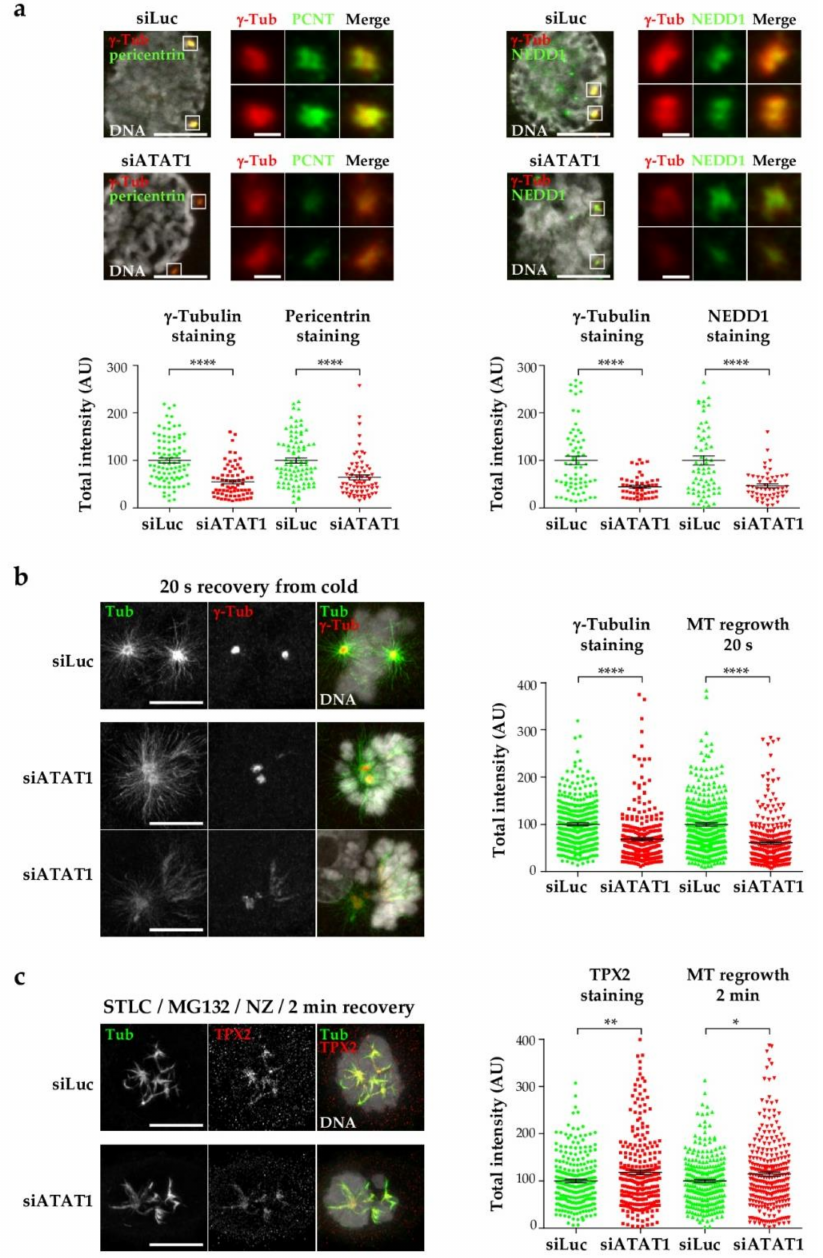
Figure 3. Centrosome maturation and nucleation are deficient in si ATAT1 cells. LLCPK1 cells were transfected for 48 h with siRNAs directed against luciferase or ATAT1 . ( a ) Cells were fixed and processed for immunofluorescence. Representative MIP images of prophase siLuc and si ATAT1 cells stained for γ -tubulin and pericentrin (left panels) and γ -tubulin and NEDD1 (right panel) are shown. Scale bars are 9 µ m. Insets show higher magnification of the centrosomes regions (scale bars are 2 µ m). Total γ -tubulin, pericentrin, and NEDD1 levels were quantified using image J software. At least 15 cells were analyzed per condition and per experiment ( n = 3). ( b ) Cells were cold treated for 20 min and then warmed for 20 s before fixation. Left panels: representative MIP images of mitotic siLuc and si ATAT1 cells stained for tubulin, γ -tubulin, and DNA. Scale bars are 7.5 µ m; Right panel: quantification of total γ -tubulin and tubulin intensities around centrosomes after 20 s recovery from cold. At least 100 cells were analyzed per condition and per experiment ( n = 3). ( c ) Cells were treated for 24 h with 2 µ M STLC after 24 h siRNA treatment and then washed and released in MG132 (10 µ